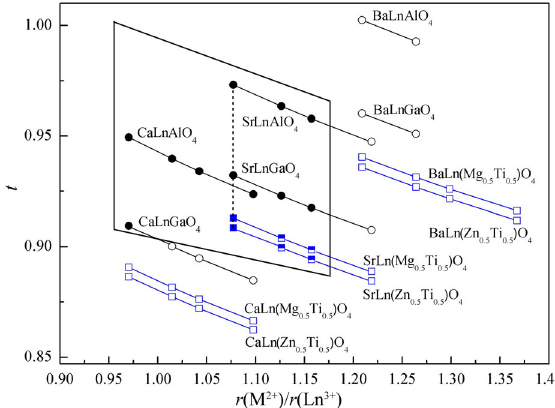
Fig. 28 Stability of K 2 NiF 4 structure in MLnBO 4 (M = Ca, Sr, Ba; Ln = Y, Sm, Nd, La; B = Al, Ga, (Mg 0.5 Ti 0.5 ), (Zn 0.5 Ti 0.5 )) compounds in relation to t and r (M 2+ )/ r (Ln 3+ ). Reproduced with permission from Ref. [573], © The American Ceramic Society